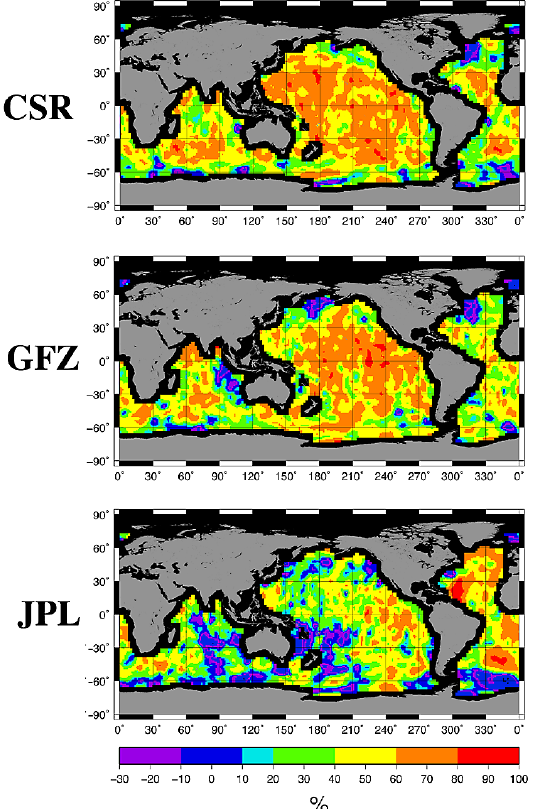
Fig. 4. Percent of variance reduced in Release-05 residuals com- pared to Release-04 residuals for coefficients processed by CSR (top), GFZ (middle), and JPL (bottom). Positive values mean the Release-05 residual variance is reduced, negative values mean that variance is increased relative to Release-04. All GRACE data were destriped and smoothed with a 300km Gaussian. Please see text and Eq. (1) for details of the